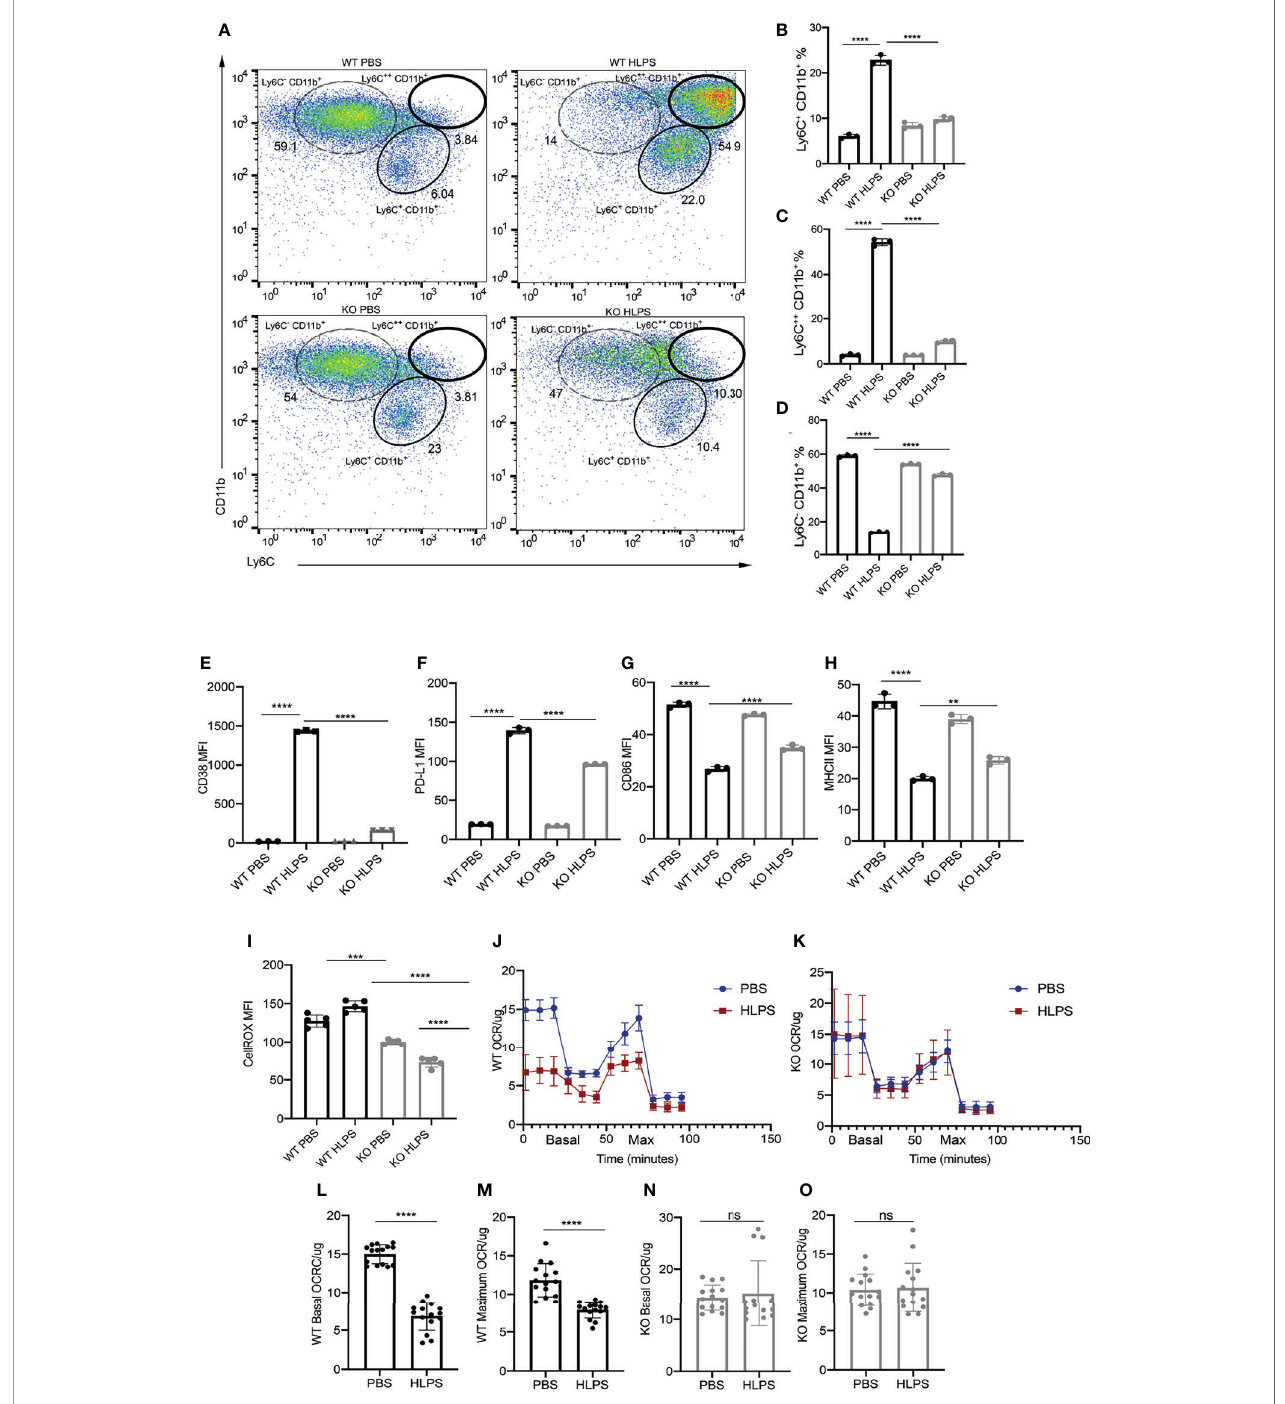
FIGURE 6 | TRAM is required for the generation exhausted monocytes. BMDMs from WT and TRAM KO mice were treated with PBS or high dose LPS (100 ng/ mL) for 5 days. (A) Ly6C + CD11b + , Ly6C ++ CD11b + and Ly6C - CD11b + populations in the cell cultures were analyzed with fl ow cytometry. (B – D) The frequencies of indicated populations were quanti fi ed, n=3. (E – H) The MFIs of CD38 (E) , PD-L1 (F) , CD86 (G) and MHC-II (H) in WT and TRAM KO monocytes were determined with fl ow cytometry. (I) Intracellular ROS levels in WT and TRAM KO monocytes were determined with fl ow cytometry, n=3. (J, K) Mitochondrial OCR/ug levels in WT (J) and TRAM KO (K) monocytes were detected with Seahorse assay, n=5. (L – O) The basal and maximum OCR/ug levels in WT and TRAM KO were compared (n ≥ 14). The data are representative of at least three independent experiments, and error bars represent means ± SEM. **p < 0.01, ***p < 0.001, ****p < 0.0001, ns: non-signi fi cant, (B – I) one-way ANOVA and (L – O) Student ’ s t